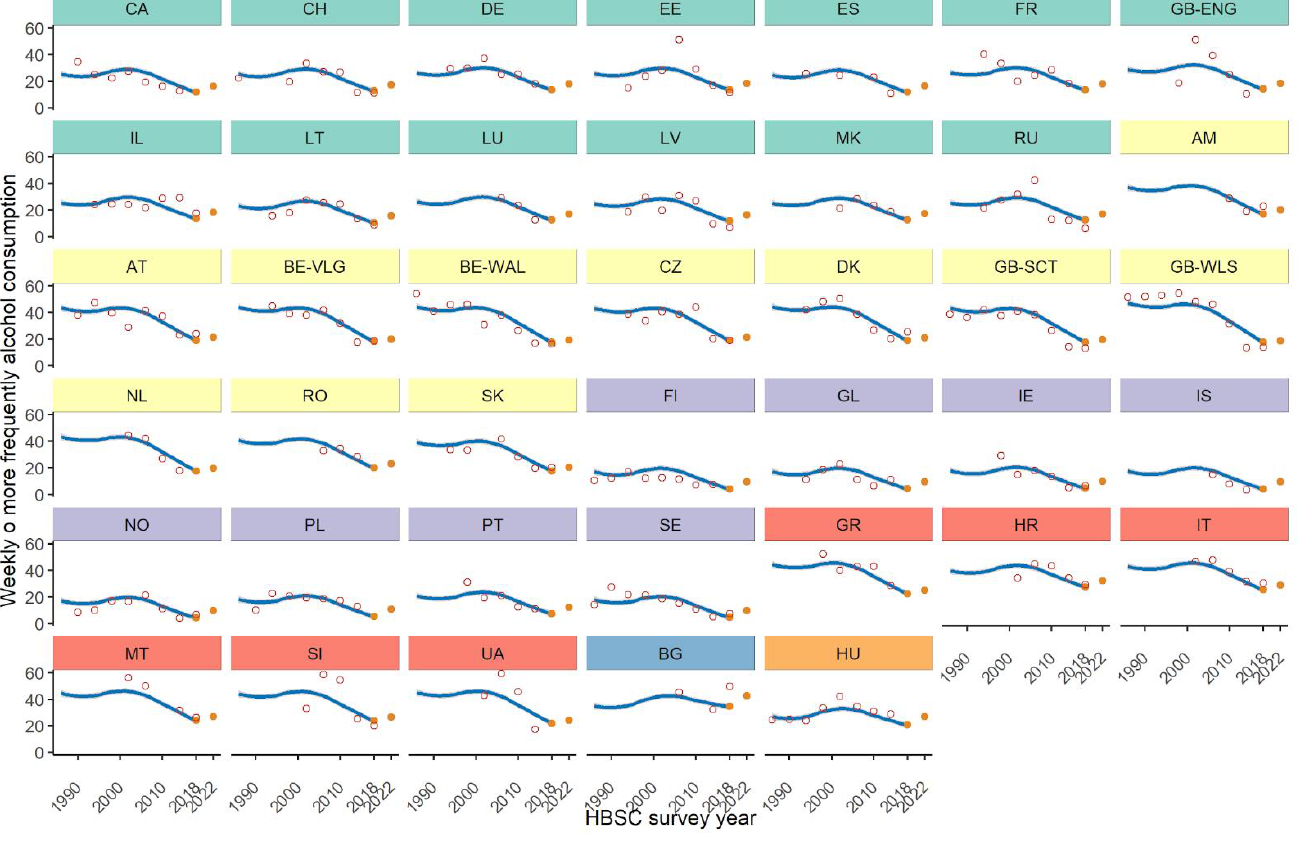
Table 3. 2021/22 estimated prevalence of weekly/daily alcohol consumption by country and gender. Country